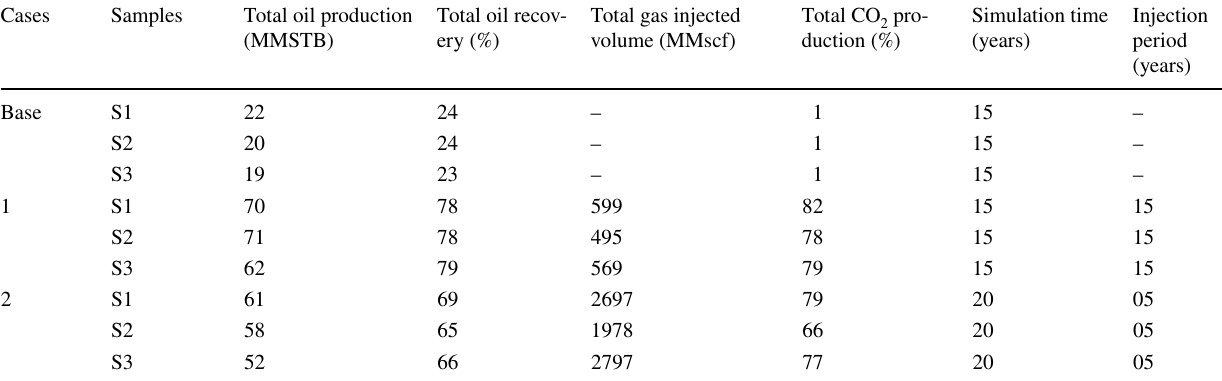
Table 4 Results for base case, case 1, and case 2